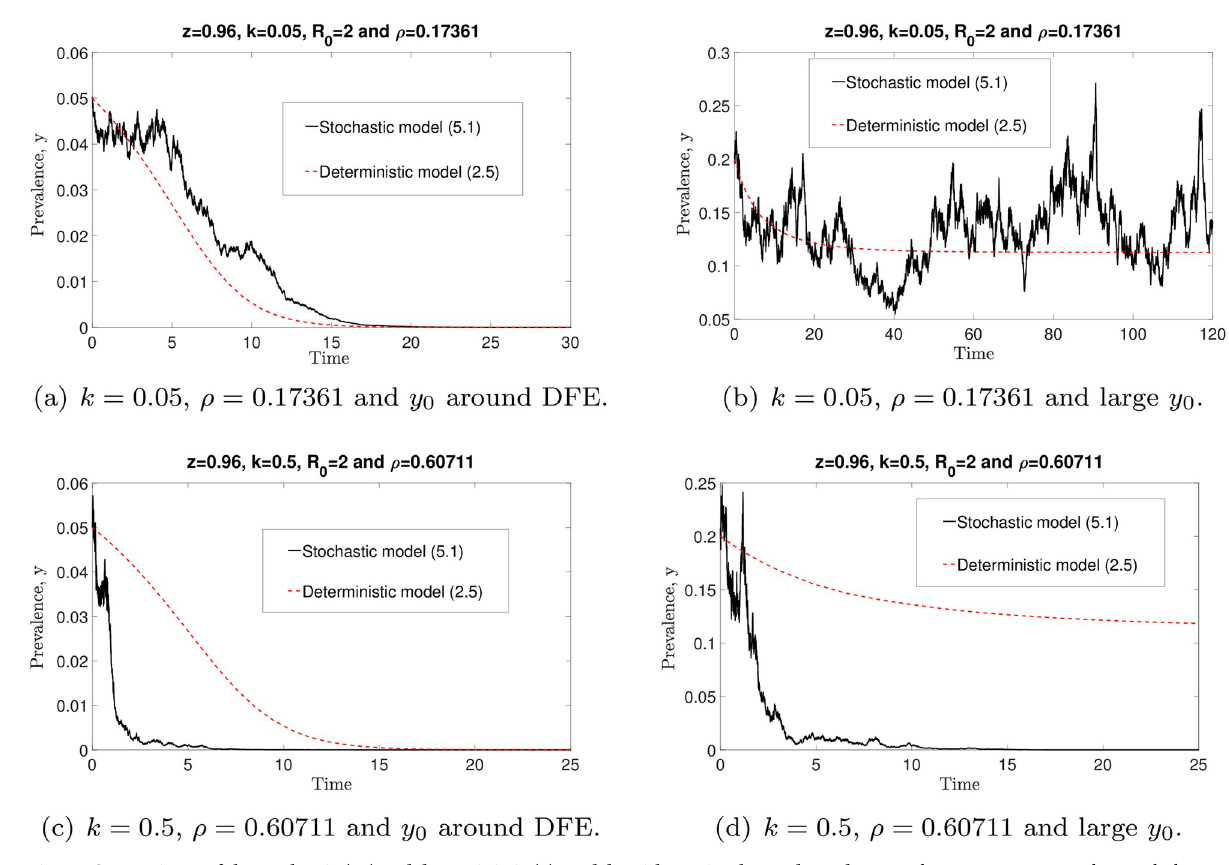
Fig 16. Comparisons of the stochastic (23) and deterministic (5) models, with varying k , ρ and y 0 values. By choosing parameter values such that the sufficient conditions as in Theorem 3 are violated, not all solutions of the stochastic model (23) approach zero. For small k and sufficiently large y 0 values, the solution of the stochastic model (23) fluctuates around the endemic equilibrium state (see